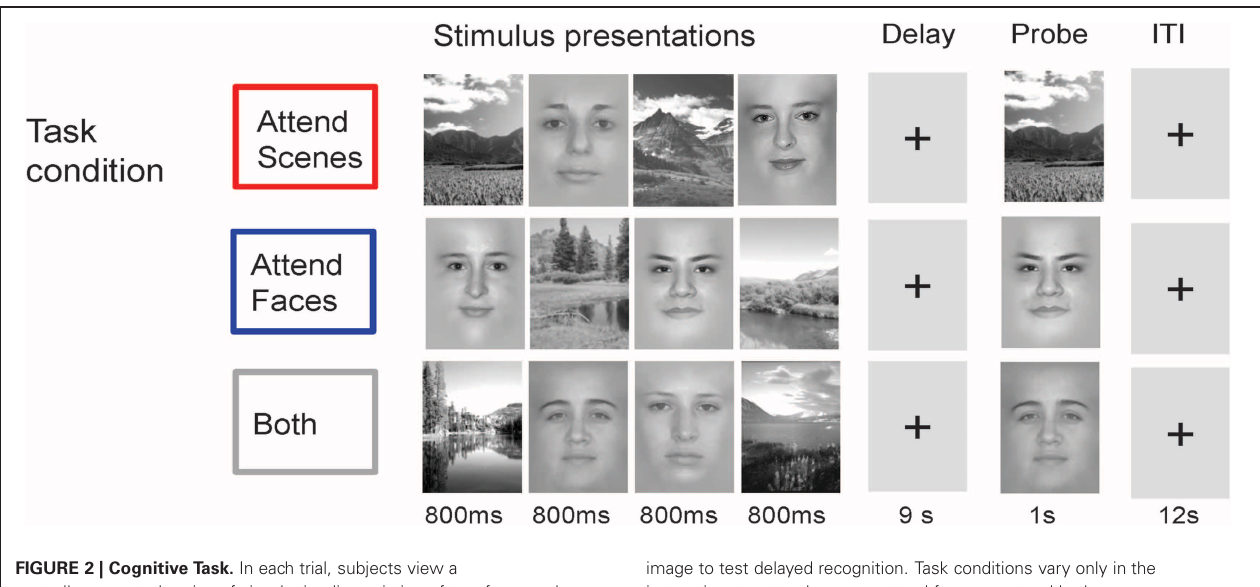
FIGURE 2 | Cognitive Task. In each trial, subjects view a centrally-presented series of visual stimuli consisting of two faces and two scenes over 4s, followed by a delay period of 9s and then a probe